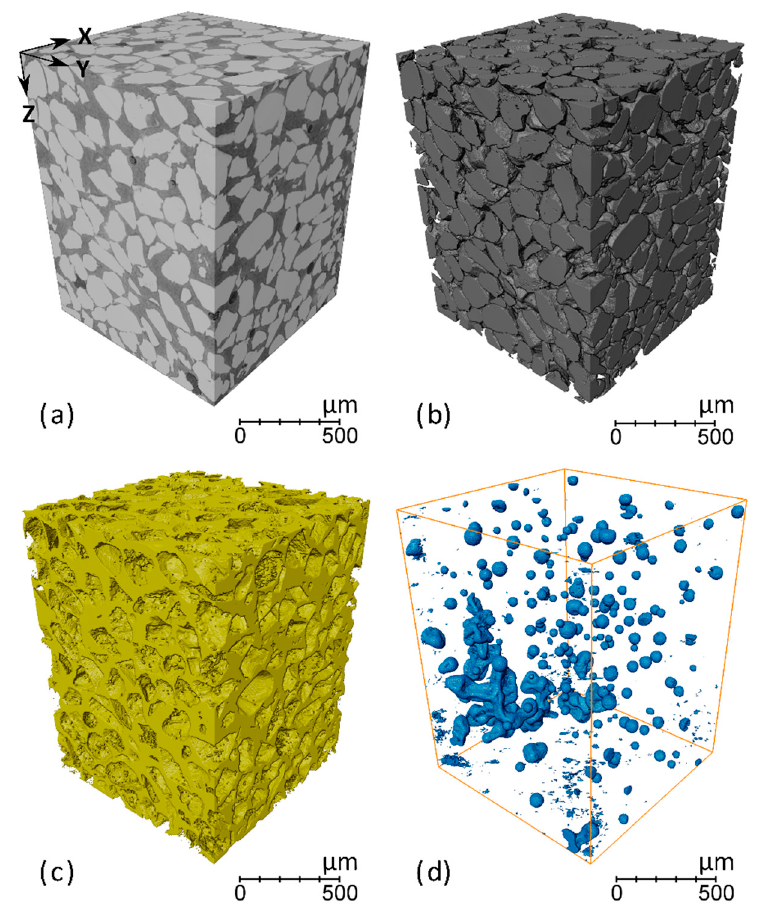
Figure 14. U-Net segmentation of an independent data set from Sahoo et al. (2018a) acquired at SLS, using a 2D multi-label single-axis U-Net model trained on the 2D learning subvolume for IC01: ( a ) reconstructed SLS volume; ( b ) sand; ( c ) brine-hydrate; ( d ) CH 4 gas.